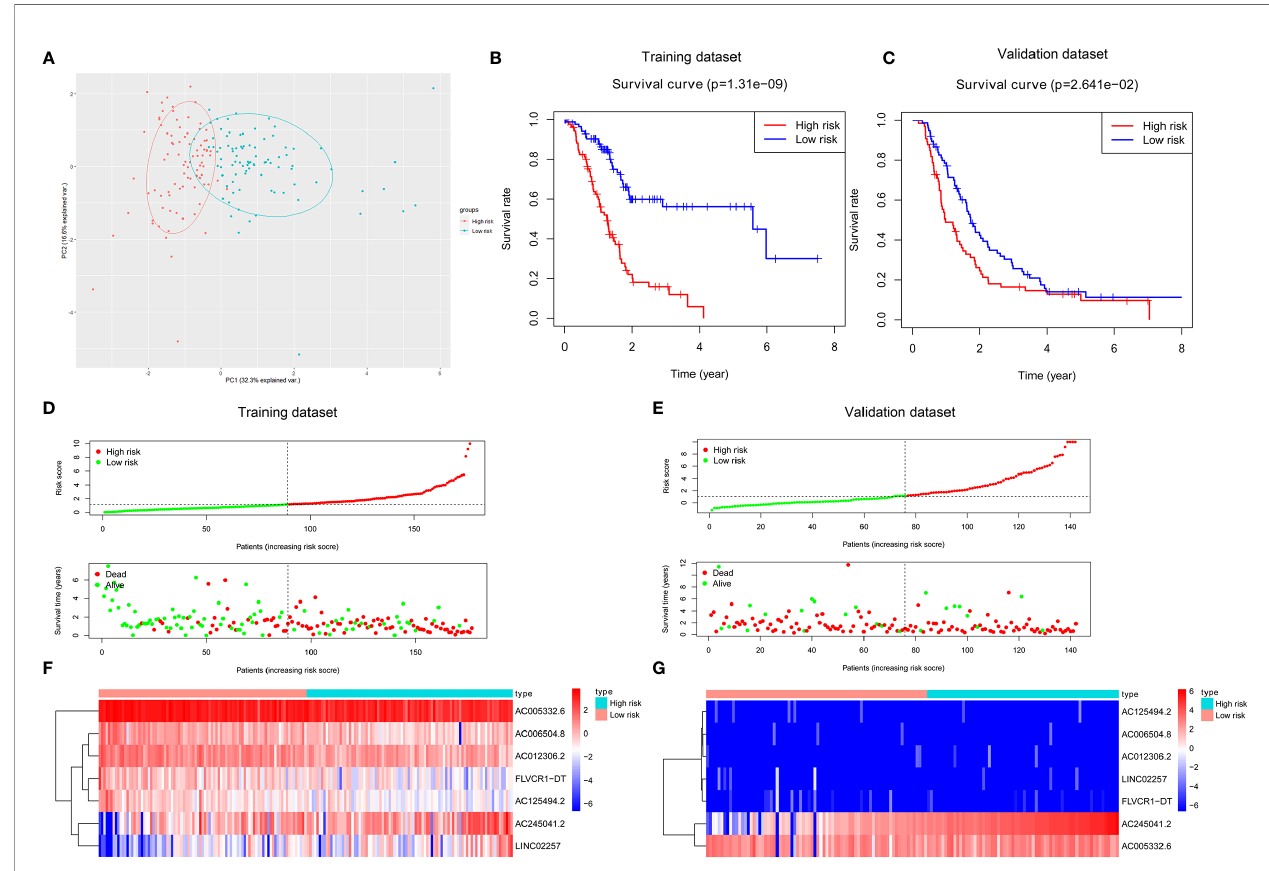
FIGURE 2 | Construction and validation of a prognostic risk score system for PC. (A) Principal component analysis (PCA) based on the high- and low-risk group indicated two signi fi cantly distinct patterns. (B, C) Kaplan – Meier survival curves showed that PC patients with high-risk scores suffered shorter survival time than those with low-risk scores in the training and validation dataset. (D, E) Risk score level between high-risk and low-risk groups. A scatter plot showed the distribution of the survival status and survival time in high- and low-risk groups. (F, G) Heatmap of the screened autophagy-associated lncRNAs expression pro fi les with different risk groups in the training and validation